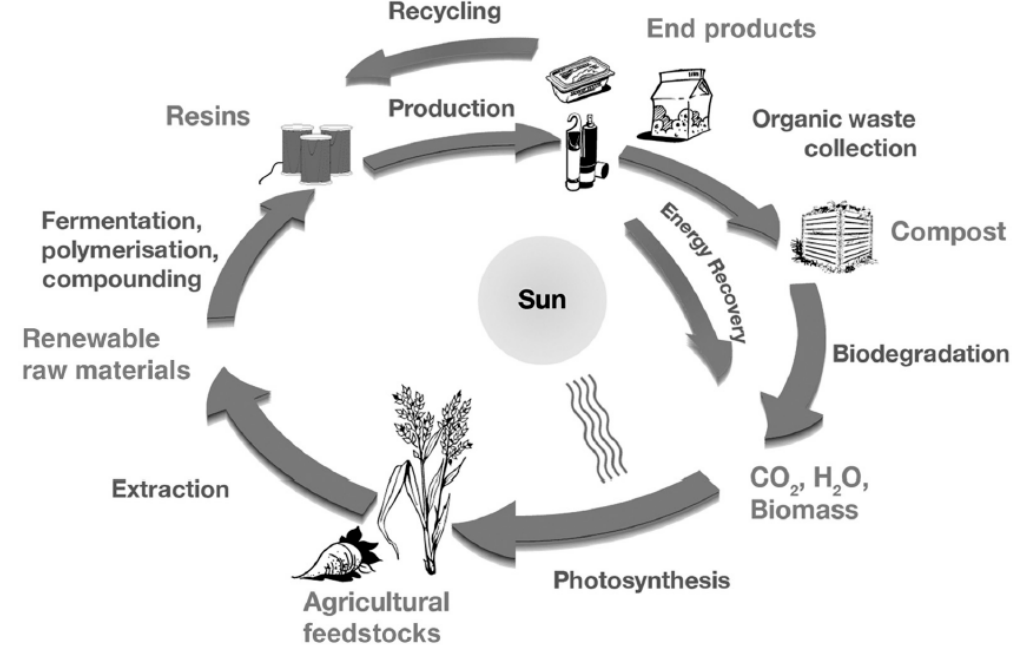
Figure 7. Lifecycle of PLA bioplastic [83].